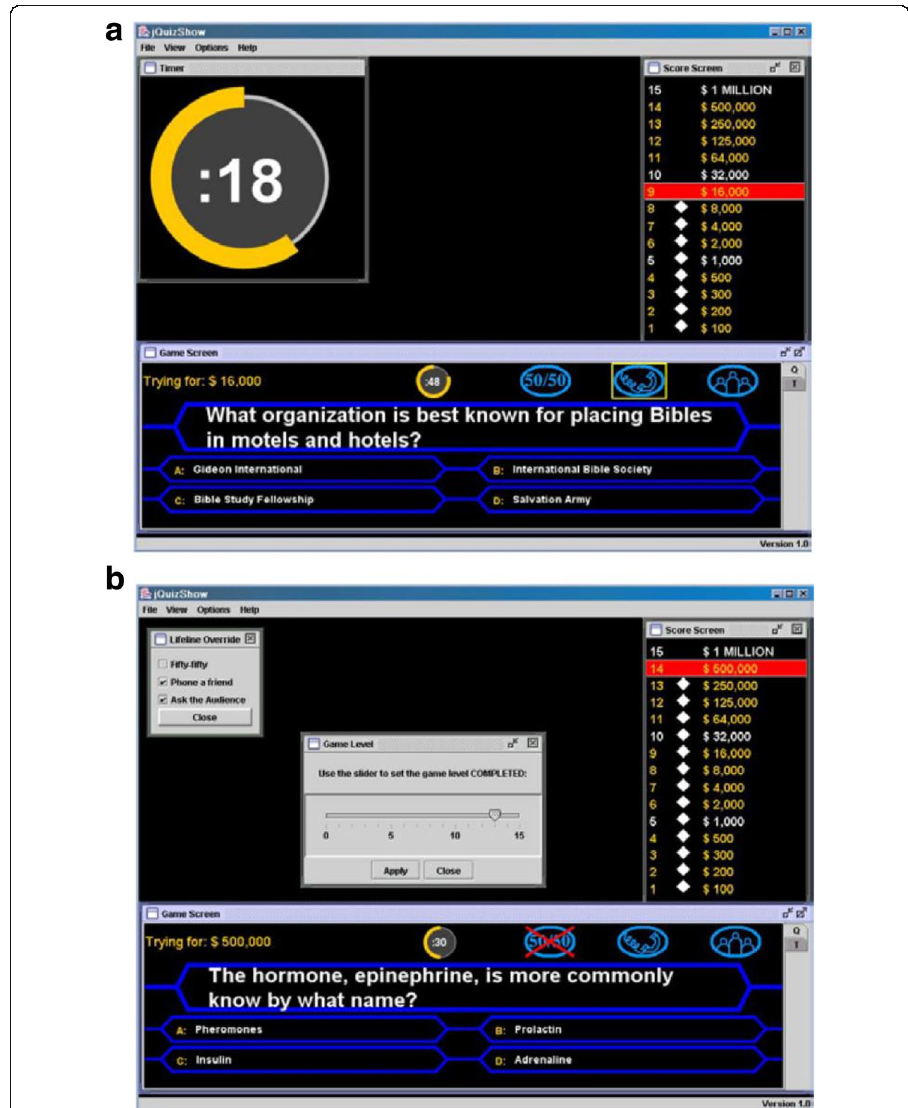
Fig. 4 a and b Screenshots from the game “ who wants to be a millionaire?